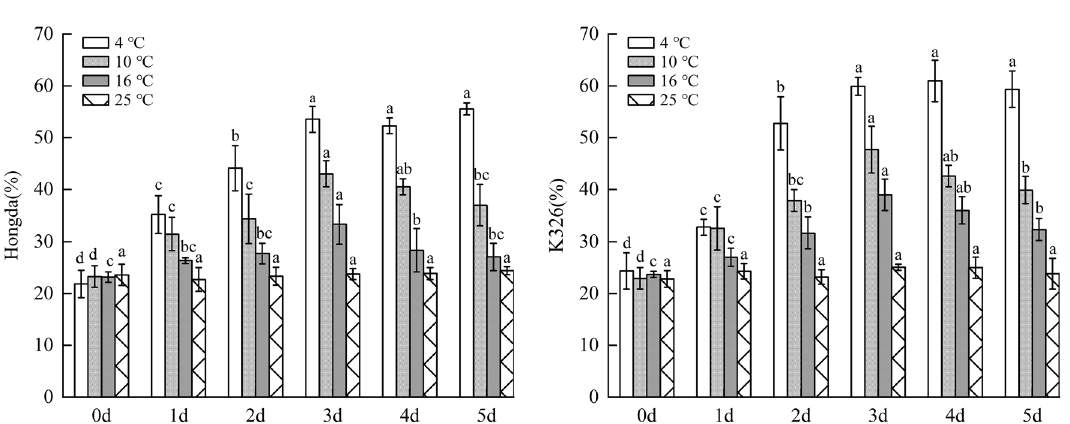
Figure 3. The changes of REC under different low-temperature stresses. Different lowercase letters indicated that there were significant differences at different times under the same temperature treatment (P < 0.05). The values were the mean of three biological